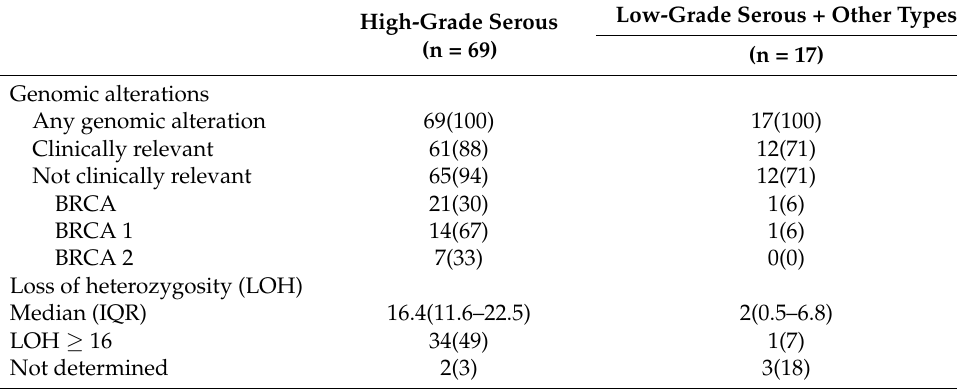
Table 3. Difference in CGP results regarding histological types.